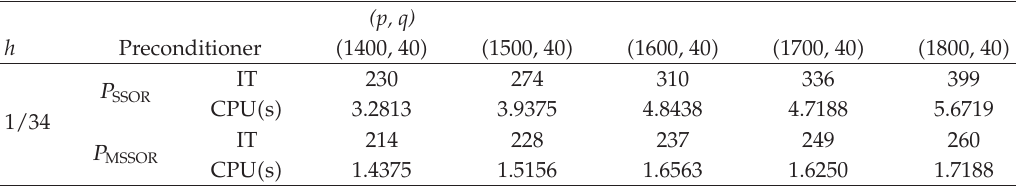
Table 2: Iteration numbers for the two-dimensional Helmholtz equations for h (cid:10) 1 / 34 meshes, using COCG with the preconditioner P SSOR and P MSSOR for solving the complex symmetric indefinite linear systems.